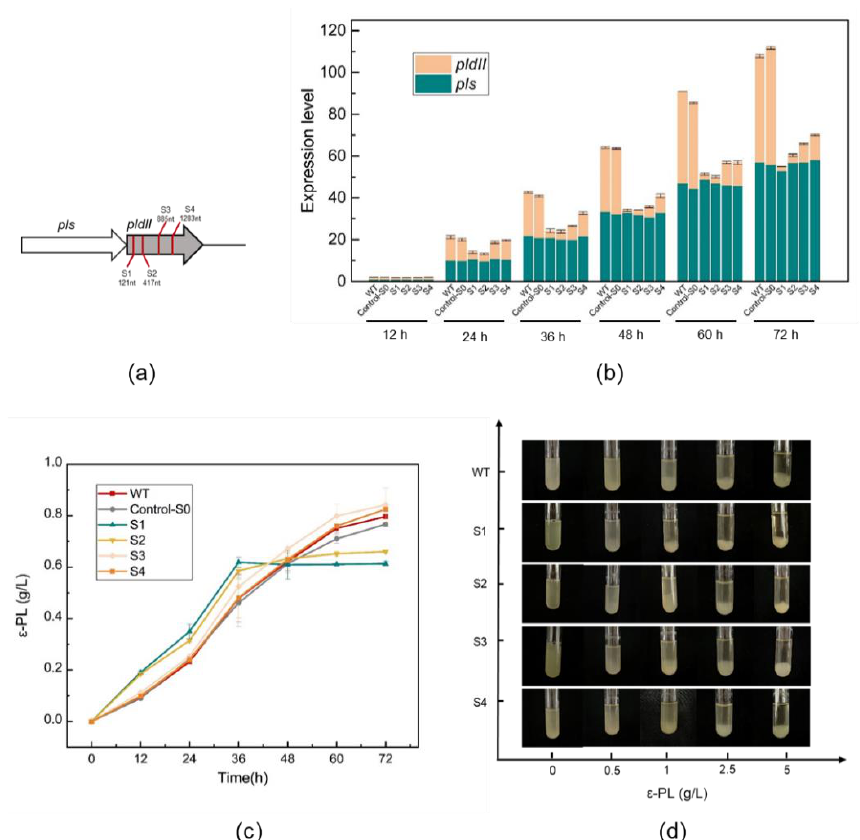
Figure 1. CRISPRi-mediated pldII repression in S. albulus . ( a ) Positions of four sgRNA protospacers on pldII ; ( b ) Transcriptional analysis of pldII and pls in S. albulus ; ( c ) Effect of pldII gene expression on the ε -PL production by S. albulus . ( d ) Effect of pldII gene expression on the minimum inhibitory concentration (MIC) for S. albulus against ε -PL. The data represent the means of three separate experiments, and the error bars represent the standard deviation. Some error bars cannot be seen due to small standard deviations.